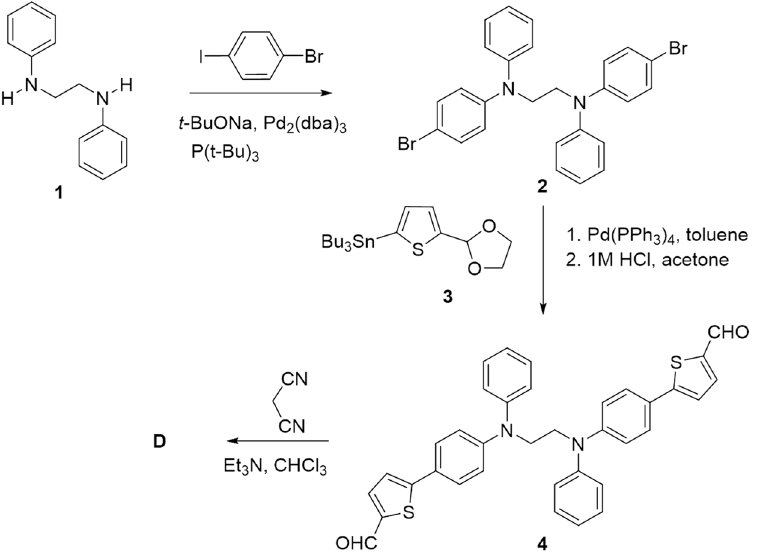
Figure 2. Synthesis of compound D